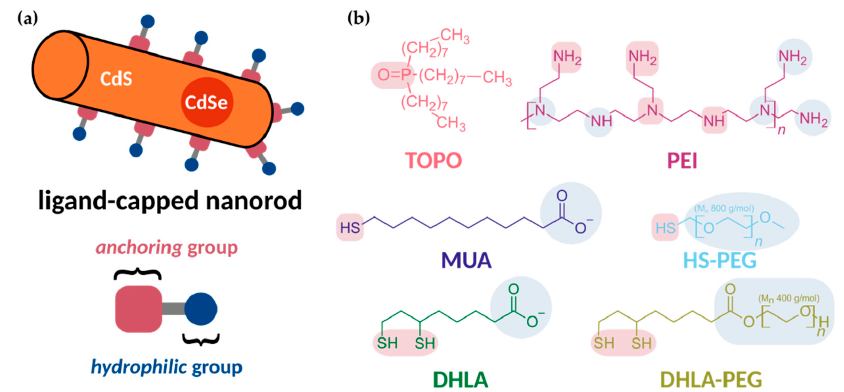
Figure 1. ( a ) Schematic sketch of a CdSe@CdS nanorods (NR) with ligands attached on the surface. The red rectangle represents an anchoring group to the surface, the blue one a hydrophilic functionality of the ligand. ( b ) Chemical structures of the ligands used in this work. While NR capped with trioctylphosphine oxide ( TOPO ) are only dispersible in nonpolar organic solvents, 11- mercaptoundecanoic acid ( MUA ), poly(ethylene glycol) 2-mercaptoethyl methyl ether ( HS-PEG ), dihydrolipoic acid ( DHLA ), dihydrolipoic acid poly(ethylene glycol) ester ( DHLA-PEG ), or hyperbranched poly(ethylene imine) ( PEI ) capped NR can be dispersed in water. In all structures,